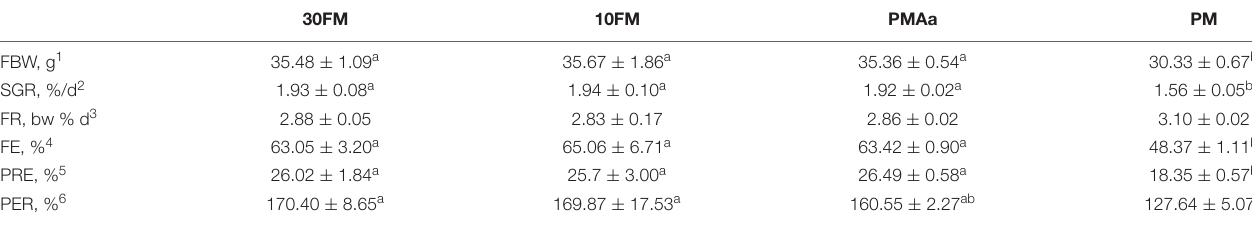
TABLE 6 | Growth performance, feed utilization of gibel carp fed with different experimental diets.